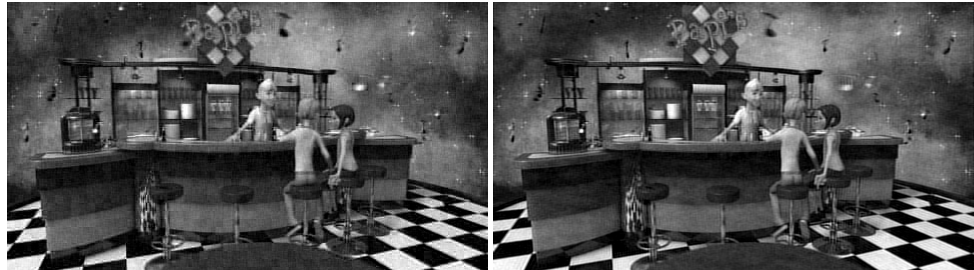
Figure 19. “Life” frames received from a transmission with a bandwidth ratio of 0.01 and a SNR of 15dB. Video with full HD resolution extracted from [39]. Left-hand side : JSCC-Cast with a SSIM quality of 0.62. Right-hand side : Softcast with a SSIM quality of 0.67.